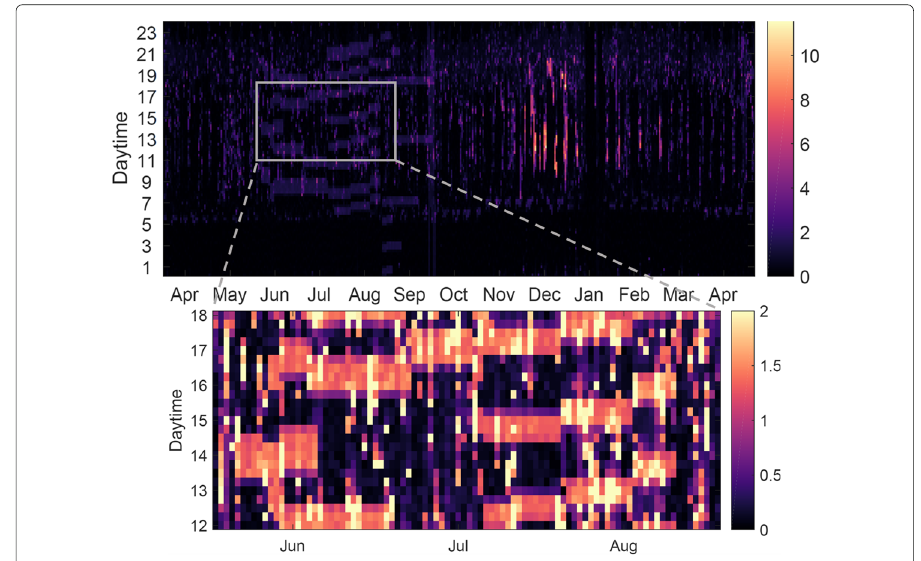
Fig. 2 top: This household’s pool pump runs less regularly such that the features are more difficult to detect from the load in the top graph. bottom: The maximum value of the detail below is set to 2 kW to make the rectangular pool pump pattern more